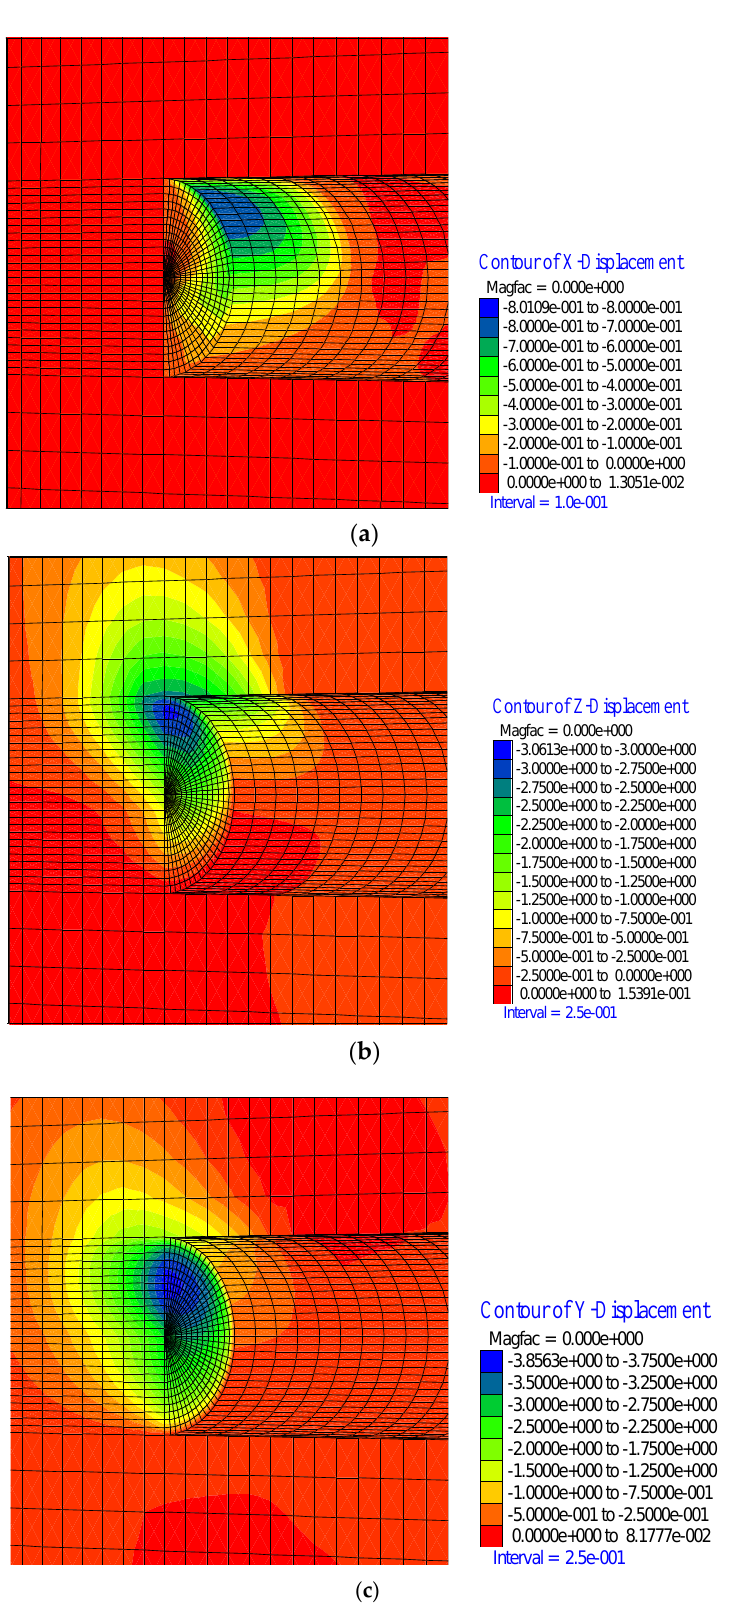
Figure 12. Deformation results in third stage ( a ) Vertical displacement, ( b ) Horizontal displacement, ( c ) Face displacement. (units in m).